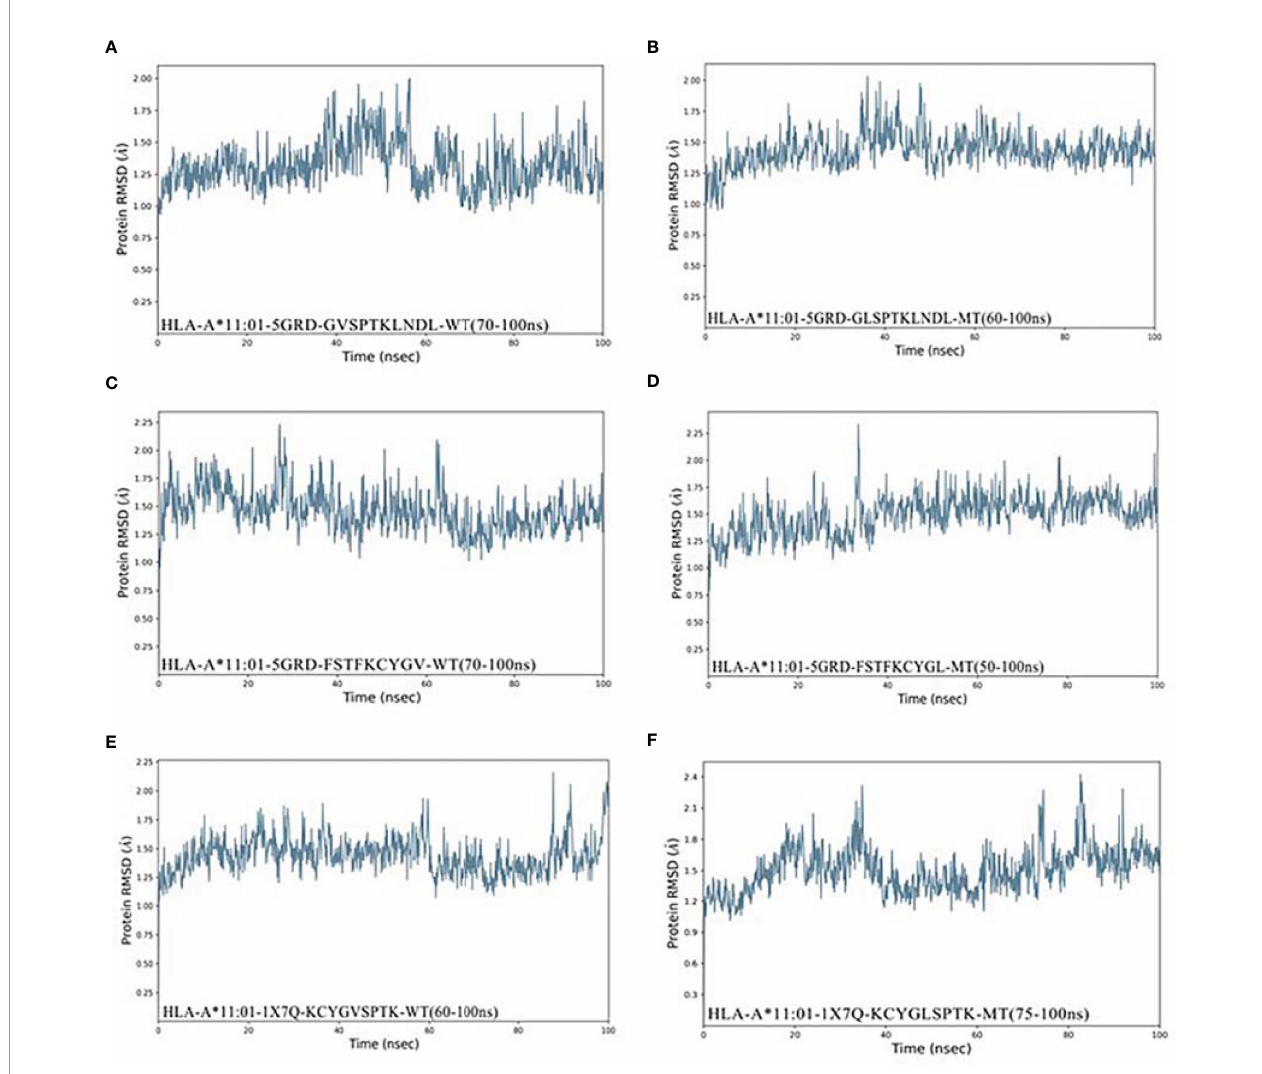
FIGURE 4 | RMSD plot of the HLA-A*11:01-epitopes based on V382L. (A) HLA-A*11:01(5GRD)-GVSPTKLNDL (WT). (B) HLA-A*11:01(5GRD)-GLSPTKLNDL (MT). (C) HLA-A*11:01(5GRD)-FSTFKCYGV (WT). (D) HLA-A*11:01(5GRD)-FSTFKCYGL (MT). (E) HLA-A*11:01(1X7Q)-KCYGVSPTK (WT). (F) HLA-A*11:01(1X7Q)- KCYGLSPTK (MT). RMSD, root mean square deviation; MT, mutation type; WT, wild type.